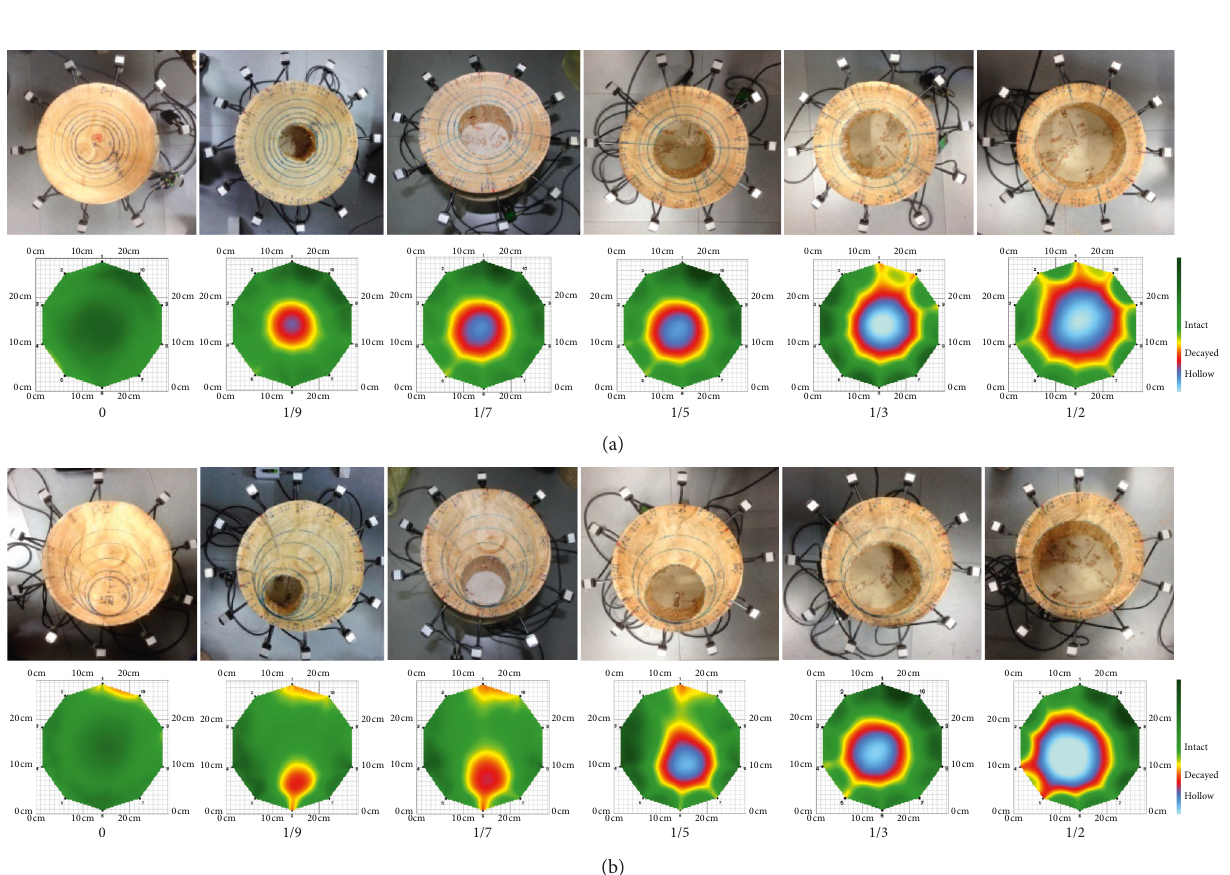
Figure 7: Image of specimens and stress wave diagrams for different stages of defect expansion for (a) the core material cavity experiment and (b) the sapwood cavity experiment.